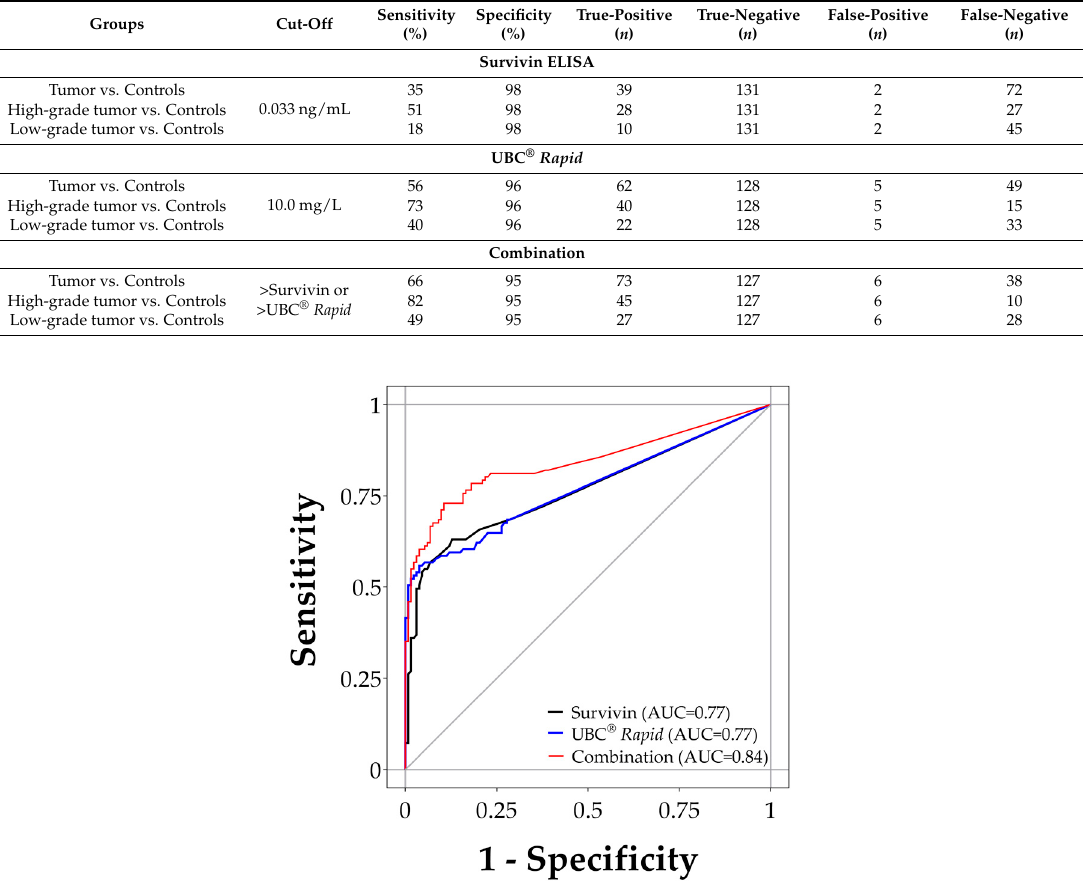
Table 3. Performance of survivin, UBC ® Rapid , and combination based on single-marker cut-off for the detection of bladder cancer.